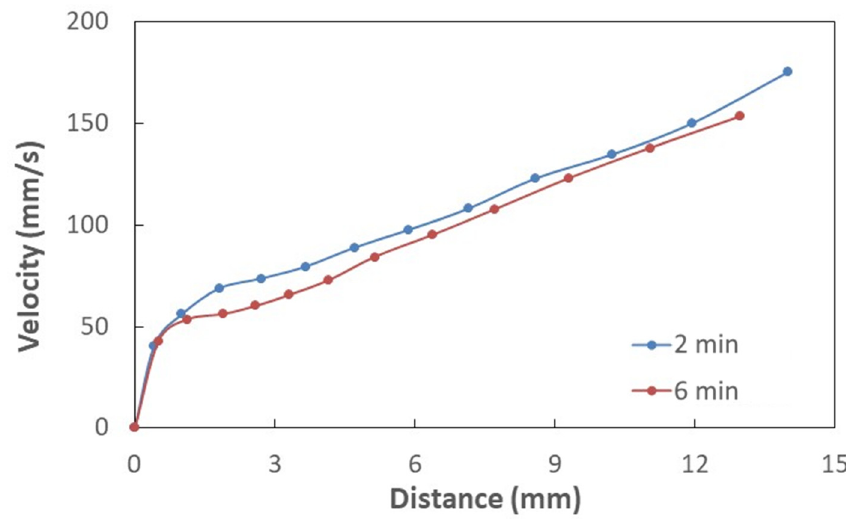
Figure 5. Water droplet translational velocity along 2 and 6 min treated surfaces. Droplet volume is 30 µL and inclination angle ( δ ) of treated surface is 10°.